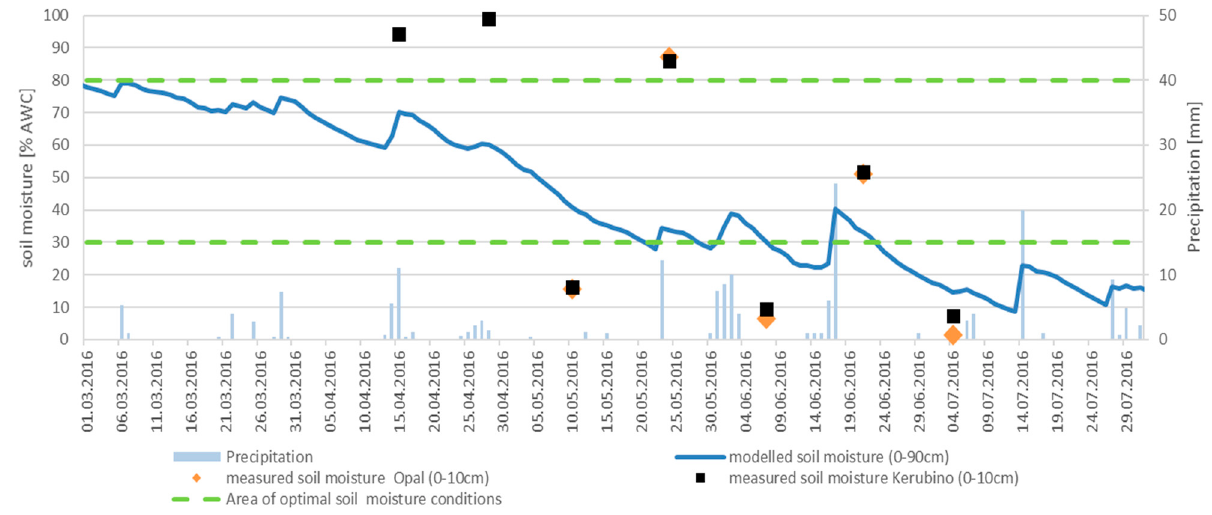
Figure 6. Modeled and measured soil moisture [% AWC] of unirrigated winter wheat plots Opal and Kerubino and precipitation [mm] in the period March to July 2016.